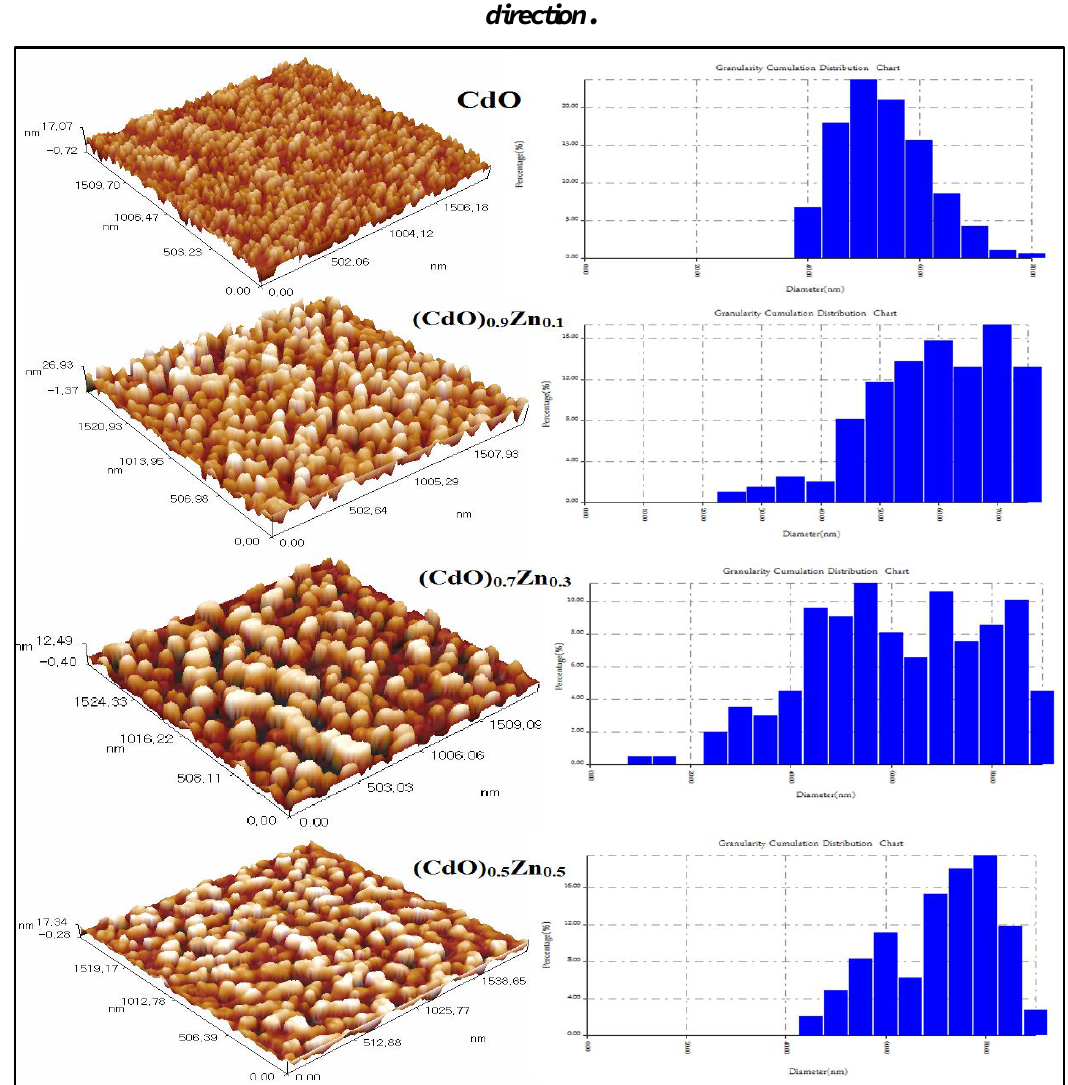
Figure 3: AFM images and their granularity accumulation distribution for pure and pure and (CdO) Zn composite thin films at different 1-x x